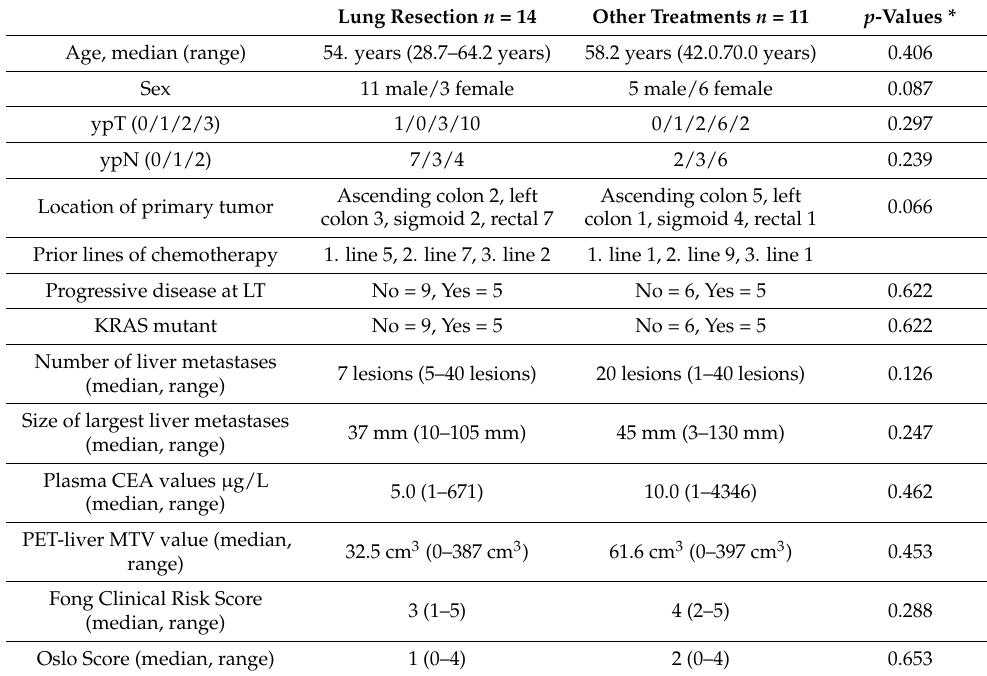
Table 1. Baseline characteristics of the 14 patients receiving resection of pulmonary metastases as first treatment after liver transplantation and the 11 patients receiving other treatments.